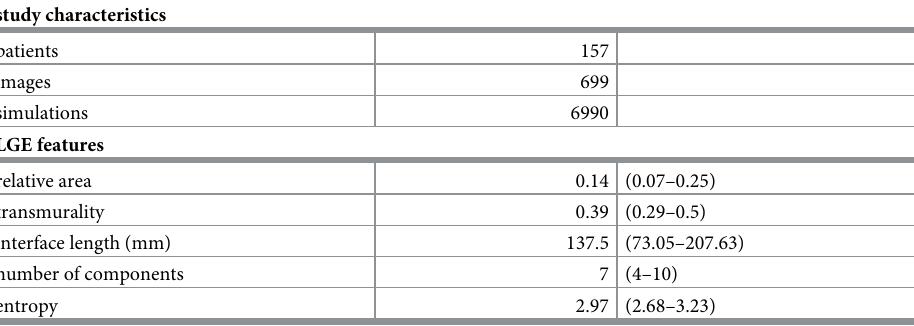
Table 1. Number of patients, images and simulations, along with LGE feature distribution given as median and IQR. study